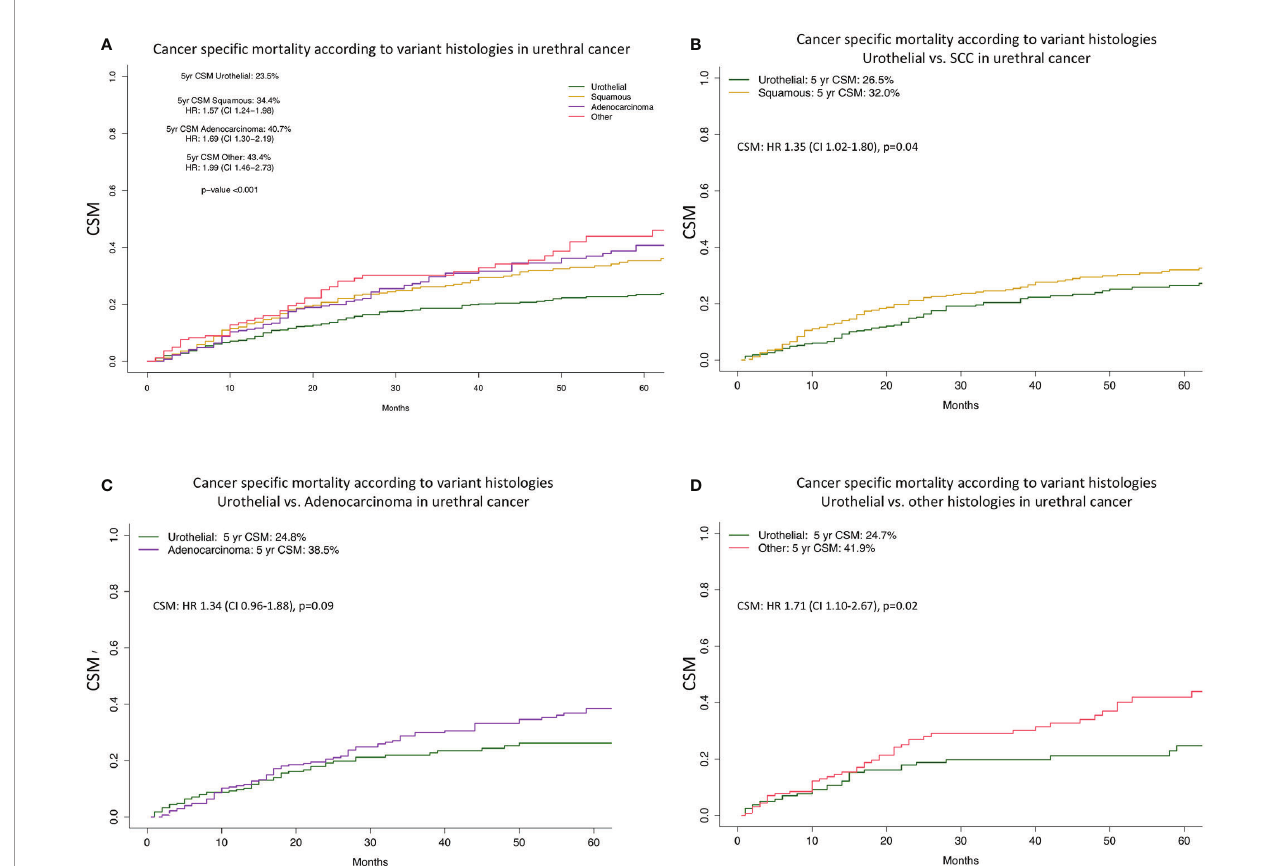
FIGURE 3 | Cancer speci fi c mortality of urothelial vs. variant histologies in urethral cancer. Cumulative incidence plots illustrating cancer speci fi c mortality (CSM) before (A) and after 1:1 propensity score matching for TNM-stage, age (B – D) . Panel (A) shows the unmatched comparison between urothelial (n = 1,009), SCC (n = 455), adenocarcinoma (n = 278), and other histology (n = 165). Panel (B) depicted the matched comparison between urothelial and SCC (both n = 435). Panel (C) depicted the matched comparison between urothelial and adenocarcinoma (both n = 278). Panel (D) depticted the matched comparison between urothelial and other histology (both n = 163). HR, Hazard ratio; CI, Con fi dence interval; CSM, Cancer speci fi c mortality; yr, year. TABLE 2 | Univariable and multivariable competing-risks regression models for urethral cancer patients (Urothelial vs. Variant histology/Urothelial vs. SCC). CSM Urothelial vs. Variant histology CSM Urothelial vs. SCC Univariable Multivariable Univariable